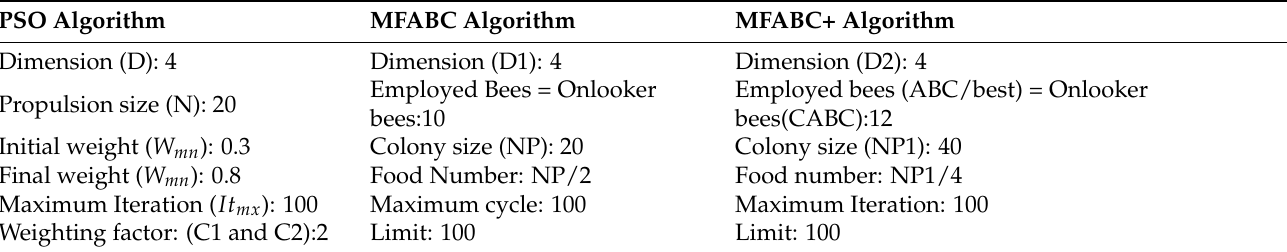
Table 3. Parameters considered for simulation using PSO, MFABC and MFABC+ algorithms. PSO Algorithm